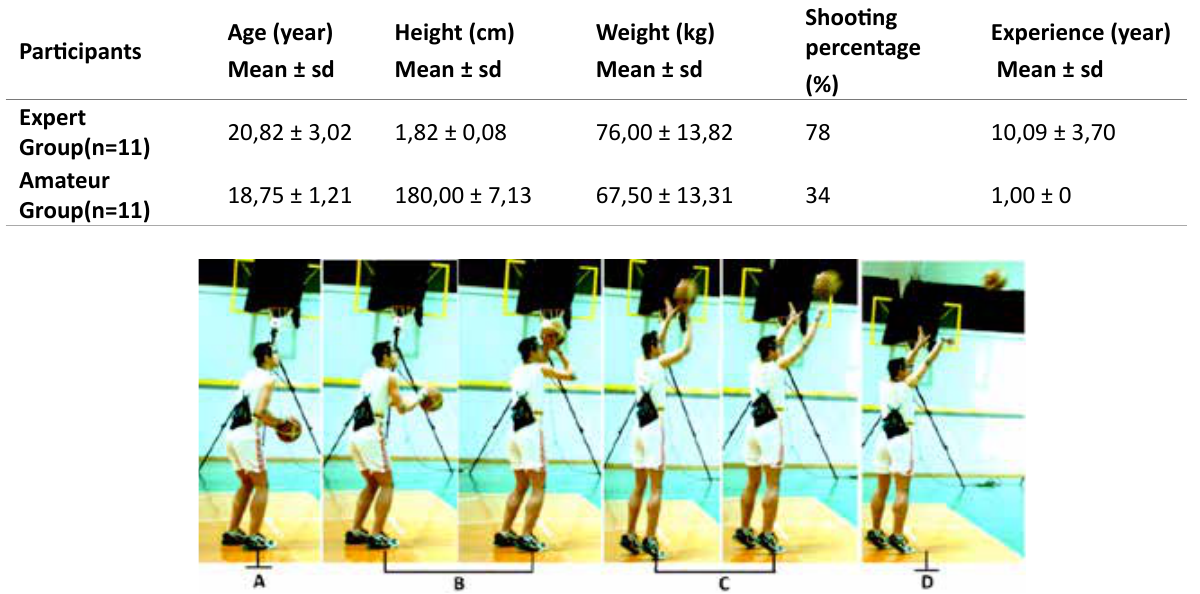
Table 1. Demographic information about basketball players and their free throw percentage accuracy values from the previous season.